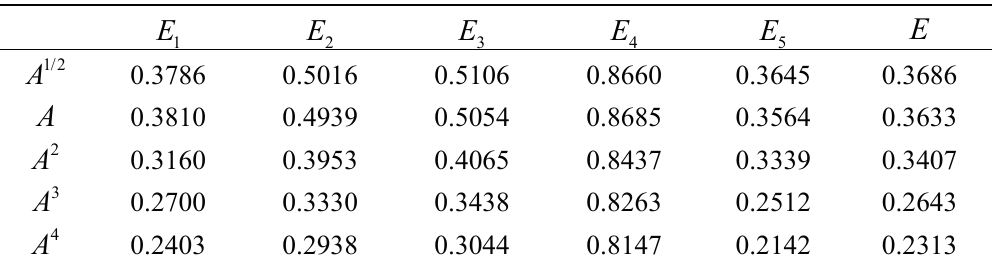
Table 1. Values of the different entropy measures under 1/2 A , A , 2 A , 3 A and 4 A . E E 1 2 1/2